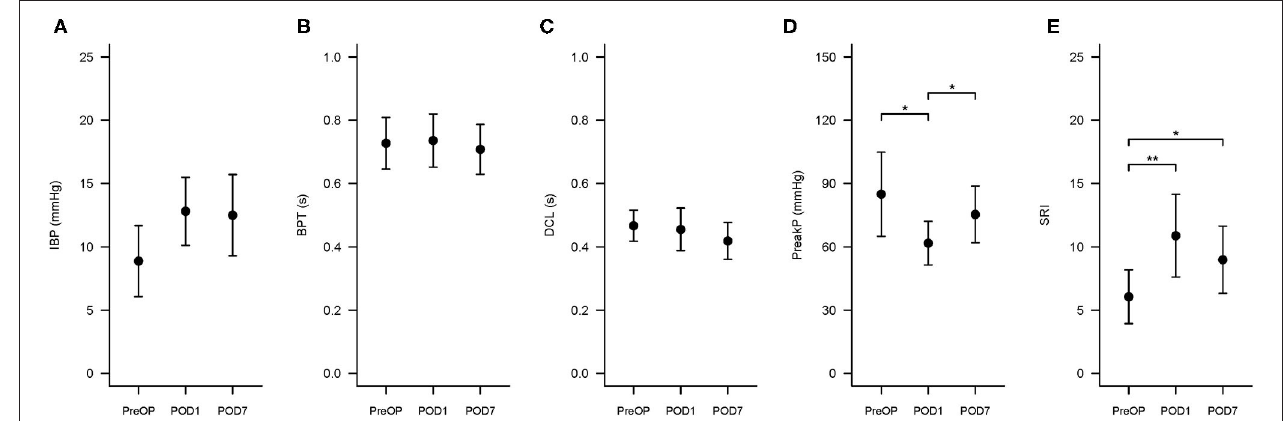
FIGURE 4 | Swallowing Risk Index (SRI) and associated hypopharyngeal parameters changes at three time points. The three time points are PreOP (preoperative day), POD1 (postoperative day 1), and POD7 (postoperative day 7). The formula to calculate SRI is (IBP × BPT)/(DCL × PeakP) × 100. (A–E) Presented the error bar of IBP, BPT, DCL, PeakP, and SRI at PreOP, POD1 and POD7, respectively. * P < 0.05; ** P < 0.01. SRI, Swallowing risk index; IBP, intrabolus pressure (mmHg); BPT, bolus present time (s); DCL, hypopharyngeal distention contraction latency (s); PeakP: hypopharyngeal mean peak pressure